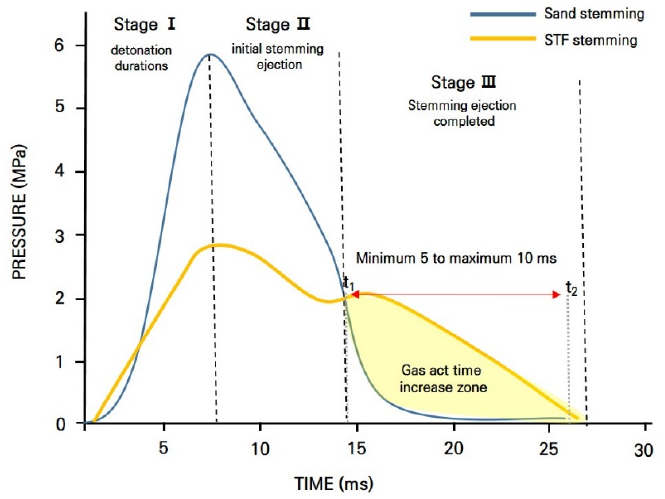
Figure 17. The time–pressure curves of the experimental results according to sand or shear thickening fluid (STF) stemming.